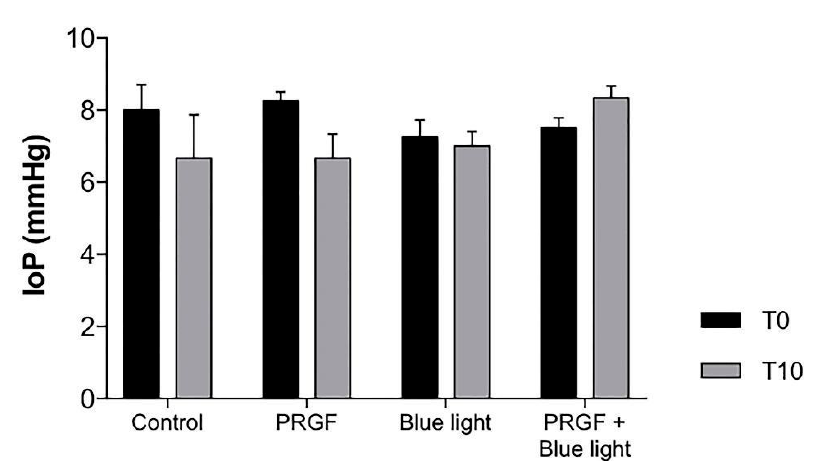
Figure 2. Intraocular pressure (IoP) values on day 0 (T0) and day 10 (T10) ( n = 4). On day 0, the IoPs from each group were similar (7–8 mmHg). On day 10, IoP values of control, blue light, and PRGF treatments decreased to a mean value of 6–7 mmHg. However, PRGF combined with blue light kept the intraocular pressure closer to basal values. Statistical analysis: Two-way ANOVA, Tukey’s multiple comparison test.